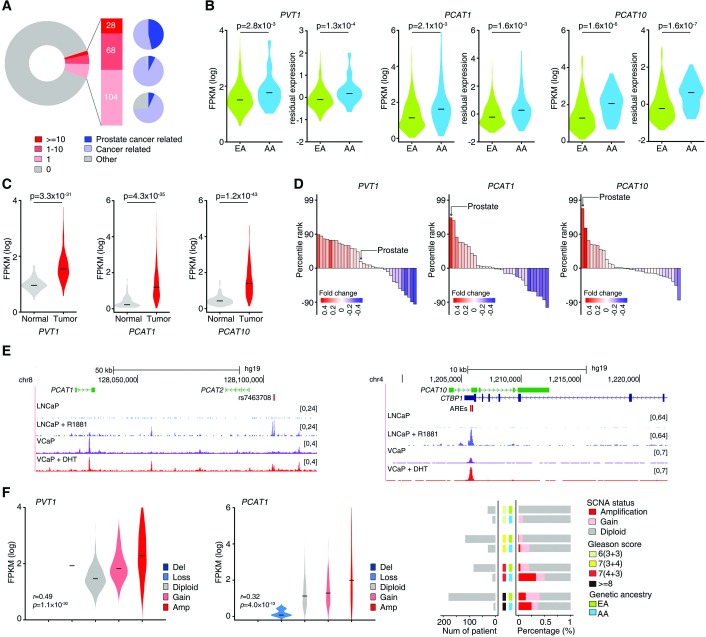
Characterization of the DE-lncRNAs PVT1, PCAT1, and PCAT10/CTBP1-AS in TCGA sample.(A) Circle plot shows the percentage of 1,868 DE-lncRNAs that have been characterized based on related publications in PubMed (left). Red and gray indicate characterized and uncharacterized DE-lncRNAs, respectively. Characterized DE-lncRNAs are defined as the lncRNAs having at least one related publication. The characterized DE-lncRNAs were further ranked into three groups, with a darker shade of red indicating a greater number of related publications. Pie charts show the percentages of the characterized DE-lncRNAs with cancer-related (light blue) or CaP-related (dark blue) results among each group (right). (B) Crude and age- and Gleason score-adjusted expression levels of PVT1, PCAT1, and PCAT10 in AA and EA patients. (C) Expression levels of PVT1, PCAT1, and PCAT10 in prostate tumors and tumor-adjacent normal prostate tissues. (D) Percentile ranks of enrichment in AA men for PVT1, PCAT1, and PCAT10 across 33 TCGA cancer types. Color of bars reflects the fold change of expression (AA vs EA) ranks in a specific cancer type relative to others. High relative expression of PCAT1 and PCAT10 among AA men is specific to CaPs, while high relative expression of PVT1 occurs across cancer types. (E) AR binding signals at genomic loci surrounding or containing PCAT1 (left) and PCAT10 (right) from AR ChIP-seq analysis of two CaP cell lines (LNCaP, VCaP) treated with synthetic androgen agonists (R1881, DHT). (F) Expression levels of PVT1 and PCAT1 by copy number status (left). Number of men and frequency of SCNAs at 8q24.21 within categories of Gleason score and genetic ancestry (right).